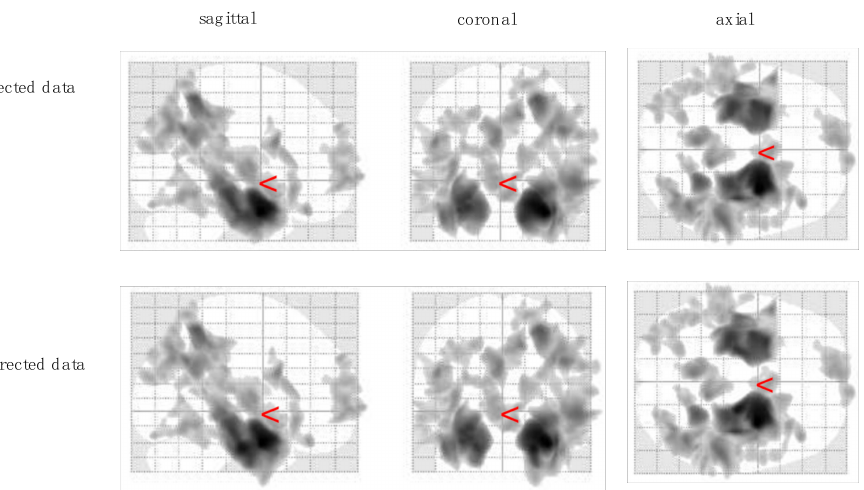
Figure 3. Results from voxel-based morphometry analysis showing grey matter clusters significantly correlating with CVLT long-delay free recall score (CVLT_LDFR). Cluster differences of corrected and uncorrected MRI data are shown in Figure 4.